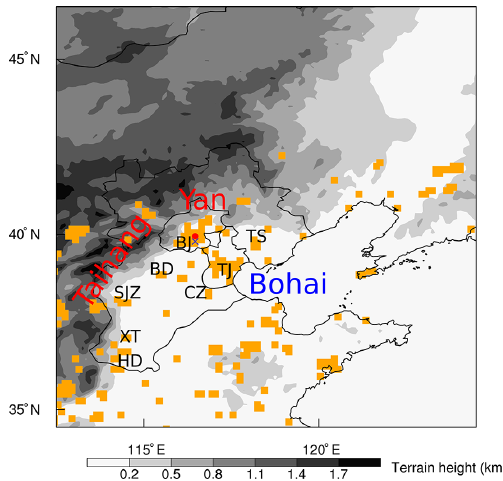
Figure 1. Spatial distribution of the terrain height of the North China Plain. Superimposed are the locations of the US Embassy air quality station (39.95 ◦ N, 116.47 ◦ E, the red dot) and the Bei- jing meteorological station (39.80 ◦ N, 116.47 ◦ E, the blue cross). Urbanized areas based on MODIS 2012 data are shown in orange. The locations of Beijing (BJ) and adjacent industrial cities are writ- ten in black text and include Tianjin (TJ), Tangshan (TS), Baoding (BD), Cangzhou (CZ), Shijiazhuang (SJZ), Xingtai (XT), and Han- dan